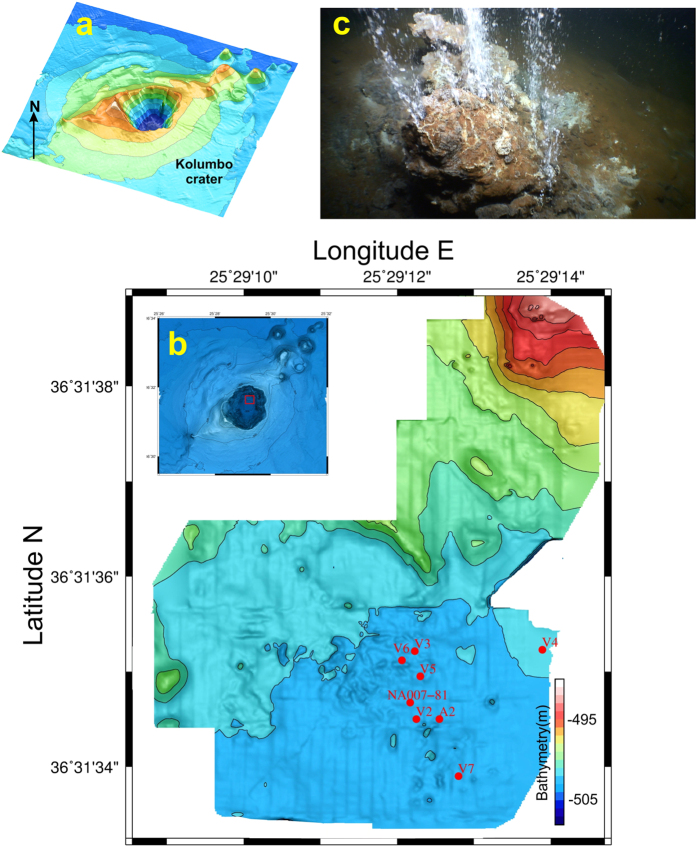
(a) 3D Bathymetric map of Kolumbo submarine volcano, showing the shape of the crater in whose bottom are located the hydrothermal chimneys; (b) High resolution swath bathymetric map of Kolumbo crater bottom (Fig. 1c) with the location of the sampled hydrothermal chimneys as labeled in Table 1. (c) Active hydrothermal vent discharging both gases (>99% CO2) and high-temperature fluids collected in this work.